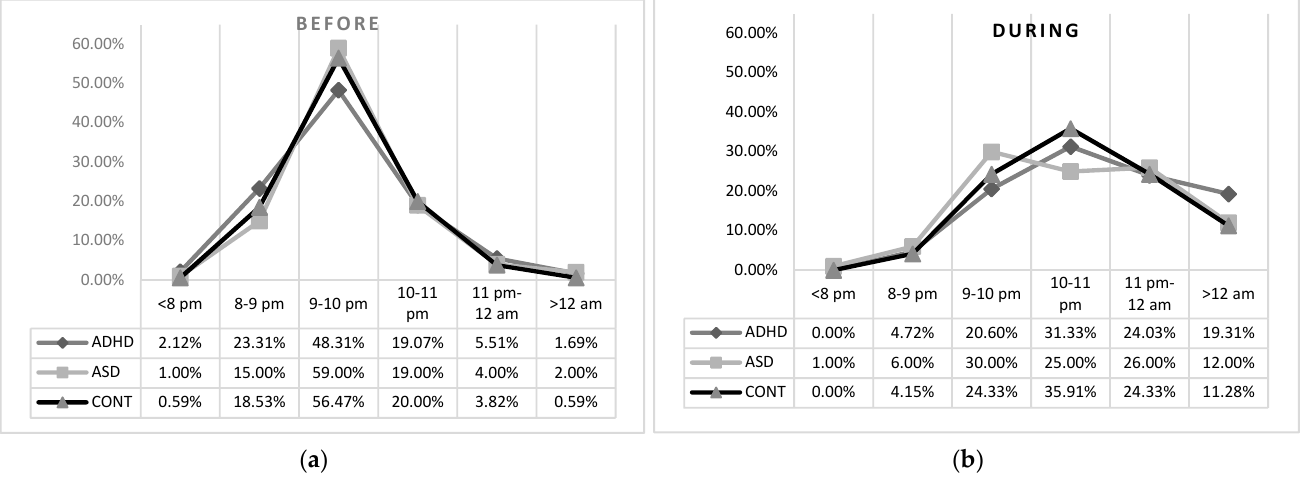
Figure 1. Bedtime before ( a ) and during ( b ) lockdown in the tree groups.